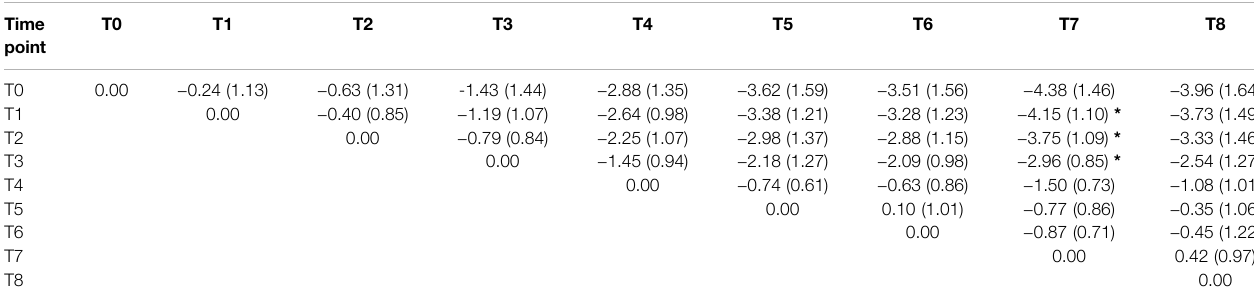
TABLE 3 | Difference between time points in the stroke volume index.